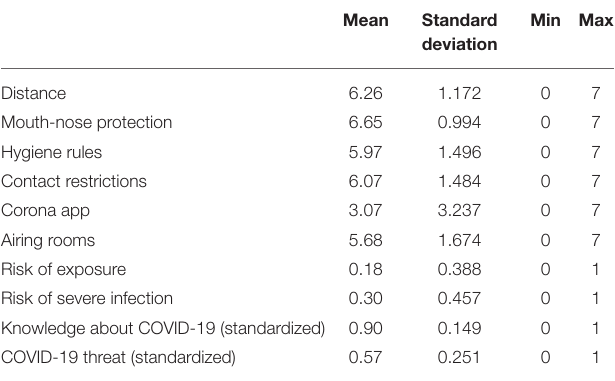
TABLE 1 | Descriptive information ( N = 4,096).